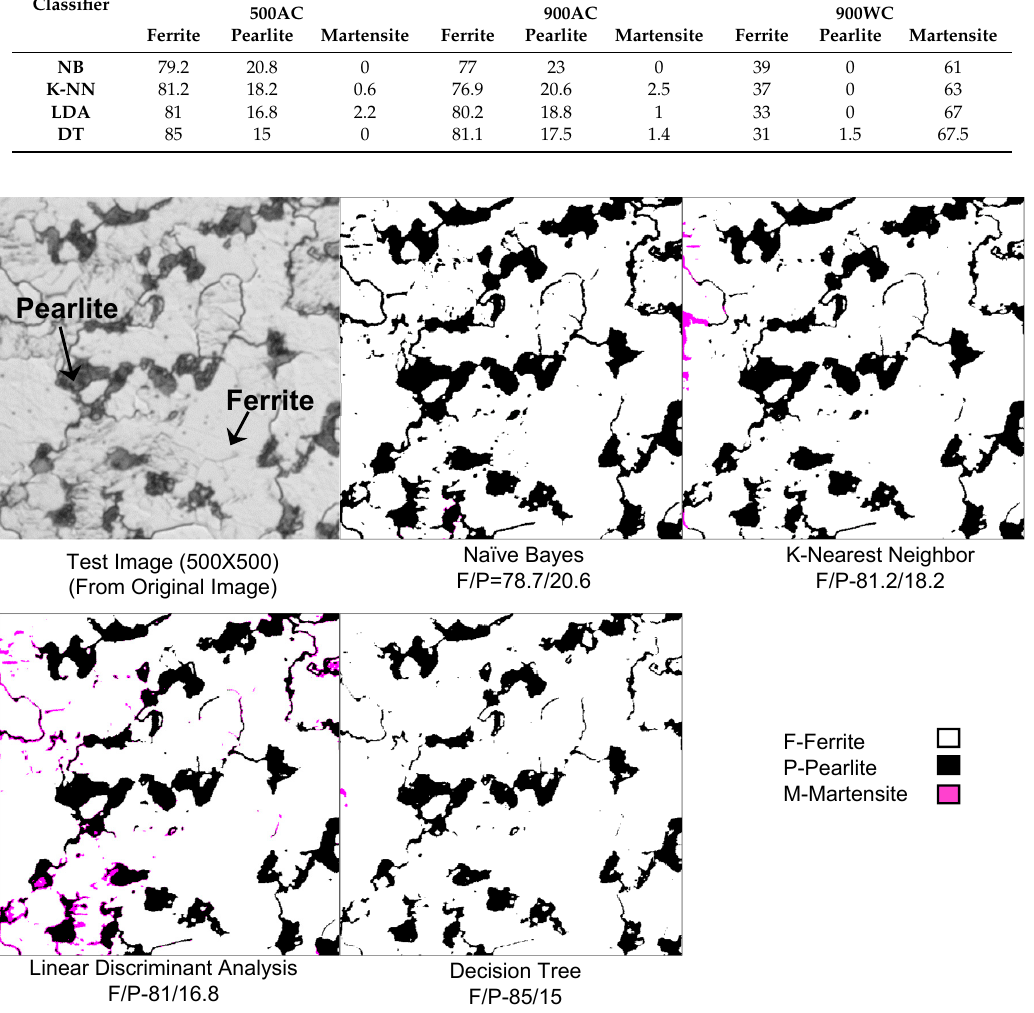
Figure 6. The microstructure of ASTM A36-500AC and machine learning-based metallurgical phase identification. All four classifiers predicted the phases accurately.